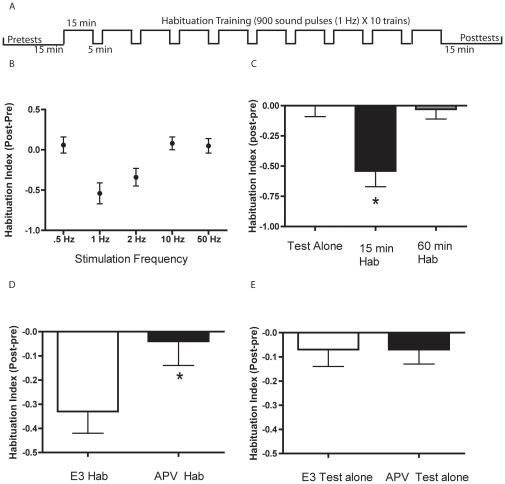
Spaced training elicited short-term habituation that depends on NMDAR activation.(A) Protocol for spaced training. (B) Habituation Indices (HI) for larvae after spaced training at different stimulus frequencies. The HI was determined by measuring the response rate of the zebrafish prior to training (3 tests, 5 min ISI) and after training (15–25 min after training; 3 tests, 5 min ISI). The posttest response rates were then subtracted from the pretest response rate to calculate the HI. The HIs for the 15–25 min posttests were: 0.5 Hz, 0.06±0.10 (n = 6); 1 Hz, −0.54±0.13 (n = 8); 2 Hz, −0.34±0.11 (n = 8); 10 Hz, 0.08±0.08 (n = 8); and 50 Hz, 0.05±.09 (n = 7). (C) Mean HI after spaced training (1 Hz) during the 15–25-min and 60–70-min posttests. There were three groups: a group that was tested 15–25 min after training (15–25 min Trained, n = 8), a group (Test alone, n = 6) that did not receive habituation training, and a group (60–70 min Trained, n = 24) that received habituation training and was tested 60–70 min after training. A one-way ANOVA indicated that there were significant differences among the three groups (F
[2,35] = 6.76, p<0.01). SNK post hoc tests indicated that the 15–25 min Trained group showed greater habituation than did the Test alone and the 60–70 min Trained groups (p<0.05 for each comparison), as indicated by the asterisk. The data used for the 15–25 min Trained group was from the experiments presented in (A). (D) Blockade of NMDARs disrupted the habituation induced by spaced training. The HI of the APV Trained group (n = 15) was −0.04±0.10, whereas it was −0.33±0.09 for the E3 Trained group (n = 15) (t
[28] = 2.16; p<0.05). The asterisk indicates a statistically significant difference. (E) APV treatment did not disrupt the responsiveness of untrained fish. There were no differences between the HIs of the untrained (Test alone) group treated with APV (n = 14) and the Test alone group treated with E3 (n = 14). The mean HI for the untrained APV-treated group was −0.07±0.06), and −0.07±.07 for the untrained E3-treated group (t
[26] = 0.008, p>0.9).